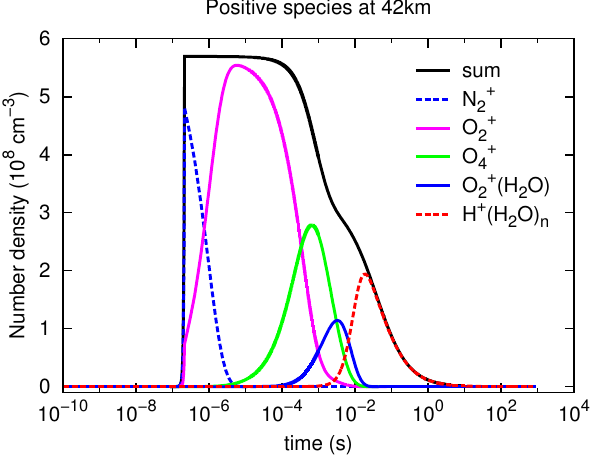
Fig. 3. Modelled evolution of the most abundant positive ions in a daytime sprite streamer at 42km altitude.